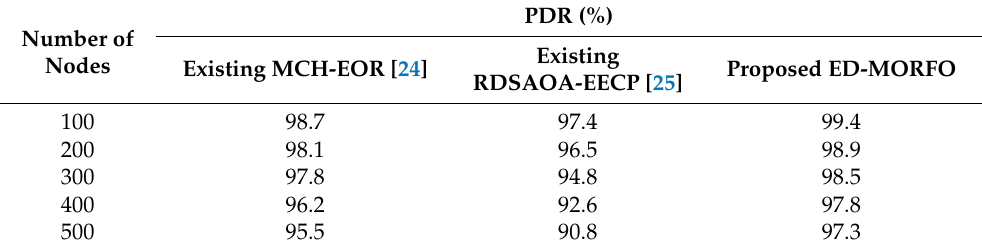
Table 4. Performances of throughput.